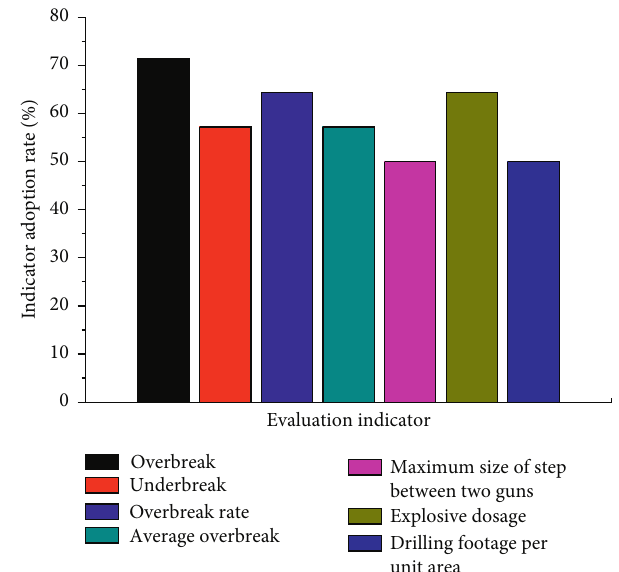
Figure 6: Very important quantitative indices (5